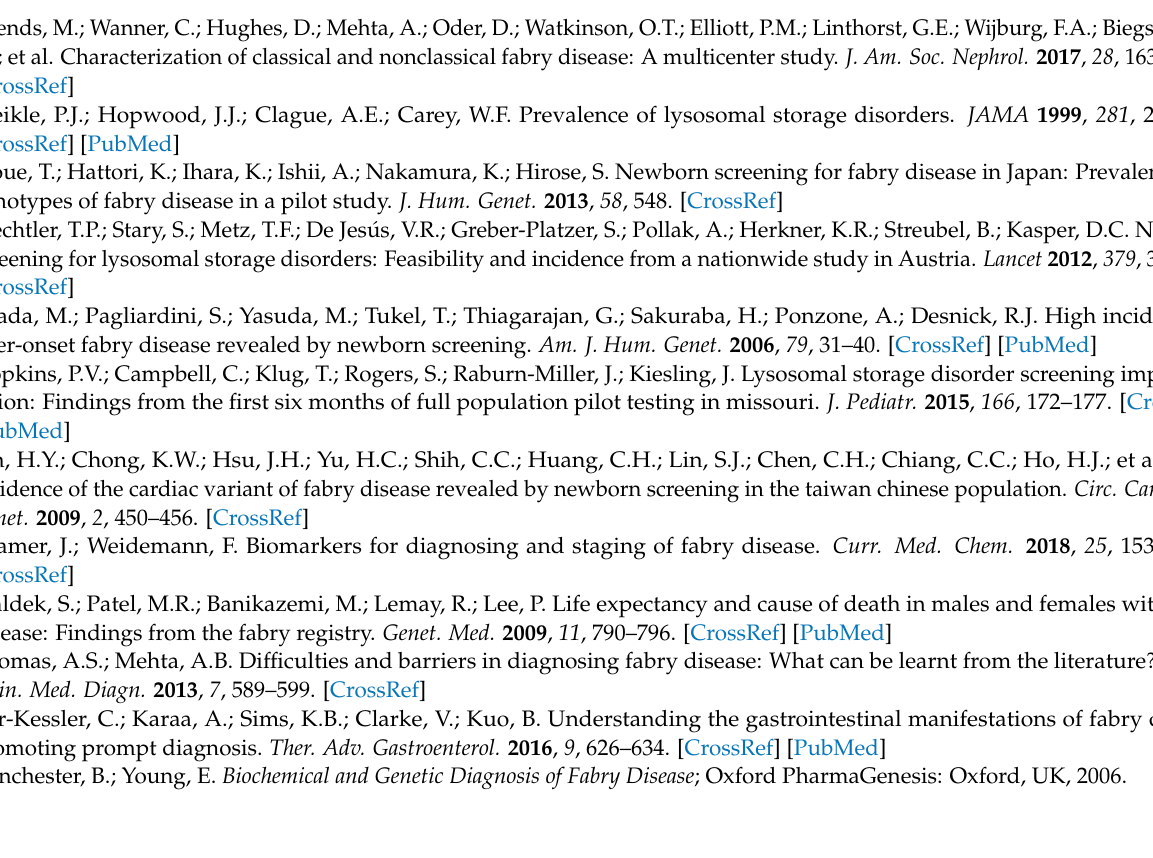
Variable metadata; Table S4: Principal Component Analysis Scores; Table S5: Differential Expression Analysis; Table S6: Metabolite Spearman Correlation Matrix; Table S7: Spearman Correlation with LysoGb3 and Residual Enzymatic Activity; Table S8: Partial Correlation Matrix including all samples; Table S9: Partial Correlation Matrix including only control samples; Table S10: Pruned network using all samples network; Table S11: Patient-specific pruned networks; Table S12: Consensus network; Table S13: All Random Forest